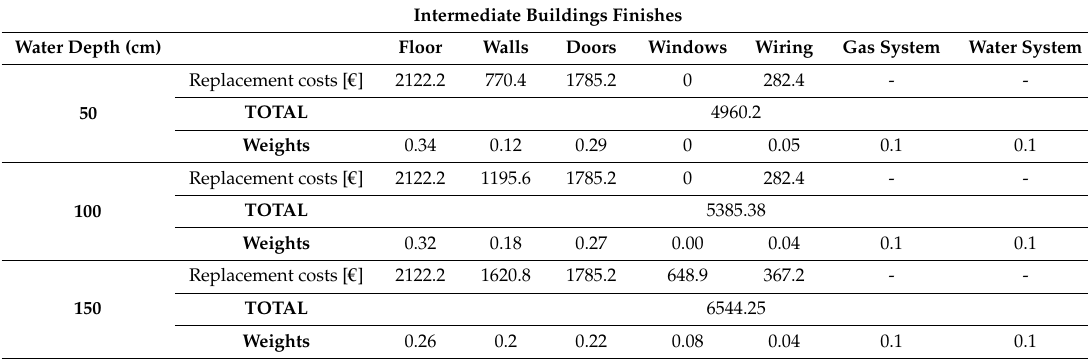
Table 3. Damage to intermediate building finishes related to water depth.